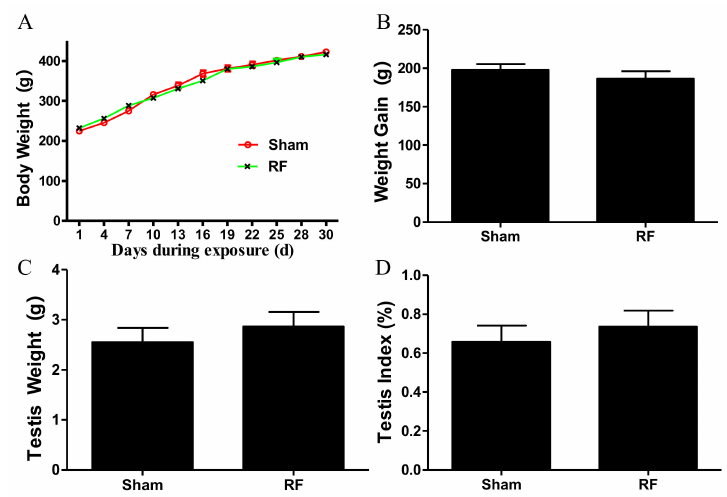
Figure 2. The effect of one-month 220 MHz pulsed modulated radiofrequency (RF) exposure on the general condition of Sprague–Dawley (SD) rats. ( A ) Growth curve of body weight; ( B ) Weight gain; ( C ) Testis weight; ( D ) Testis index (bilateral testes weight (g)/body weight (g) × 100). N = 20 for each group. The values were expressed as mean ± standard error of the mean (SEM) and were analyzed by repeated measure ANOVA or student t -test.